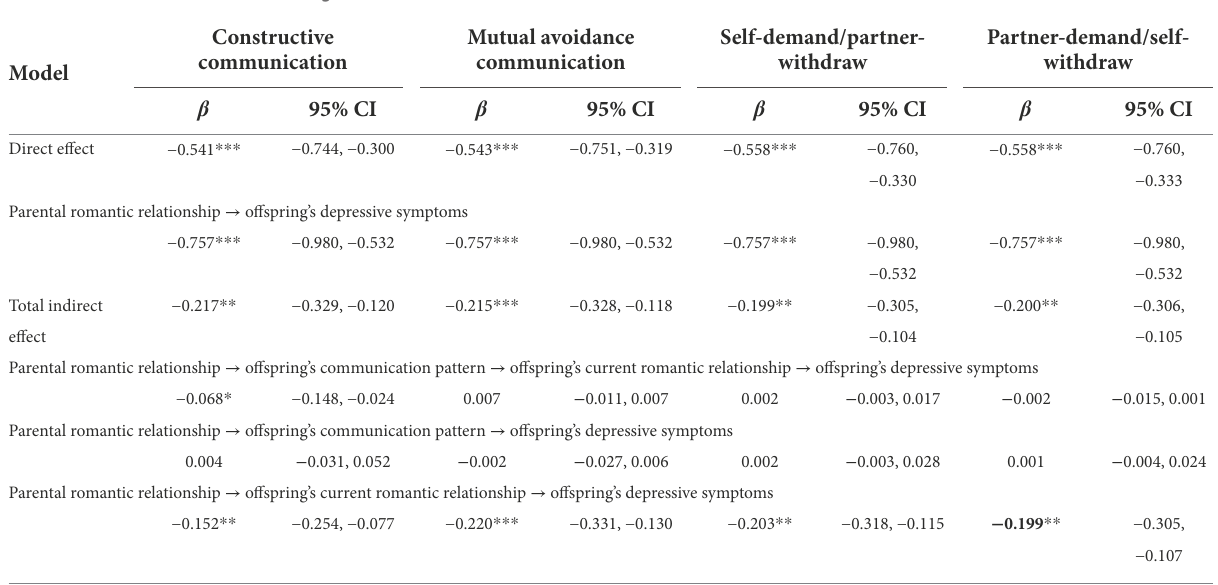
TABLE 5 Results of the chain mediating effects.